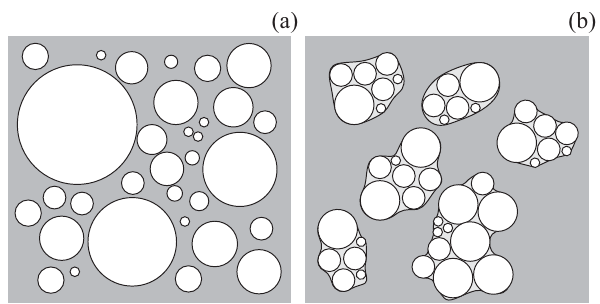
Figure 1. Two approaches to the usage of grains and bonds in DE- SIgn: without bonds, when ice floes are identical to grains and the FSD is prescribed (a) ; with bonds, when ice floes are assemblages of bonded grains and the FSD is obtained as a solution (b)